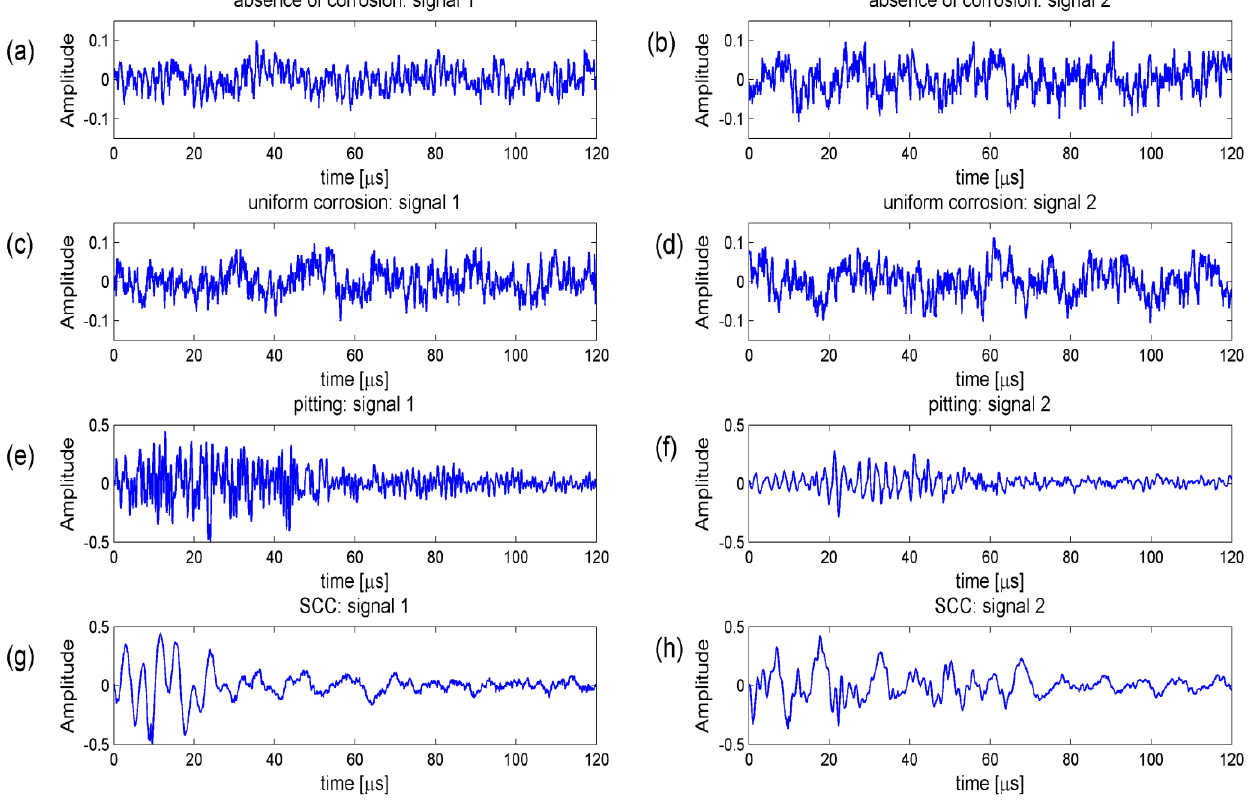
Figure 2. Example signals of different corrosion types. The example of the absence of corrosion in (a) was captured from stainless steel in CaCl environment. The example of the absence of corrosion in (b) was captured from carbon steel NaOH 20 weight% + NaCl 3 weight% at 80 °C environment. The examples in (c) and (d) are from continuous emissions during uniform corrosion of carbon steel in H 10 weight% at environment temperature. The signals in (e) and (f) are burst emission pitting signals captured from stainless steel in brackish water + FeCl environment. In (g) a SCC burst emission signal was captured from stainless steel in CaCl 40 weight% at 85 °C environment; (h) SCC burst emission signal was captured from carbon steel Ca(NO ) 60 weight% at 105 °C 3 2